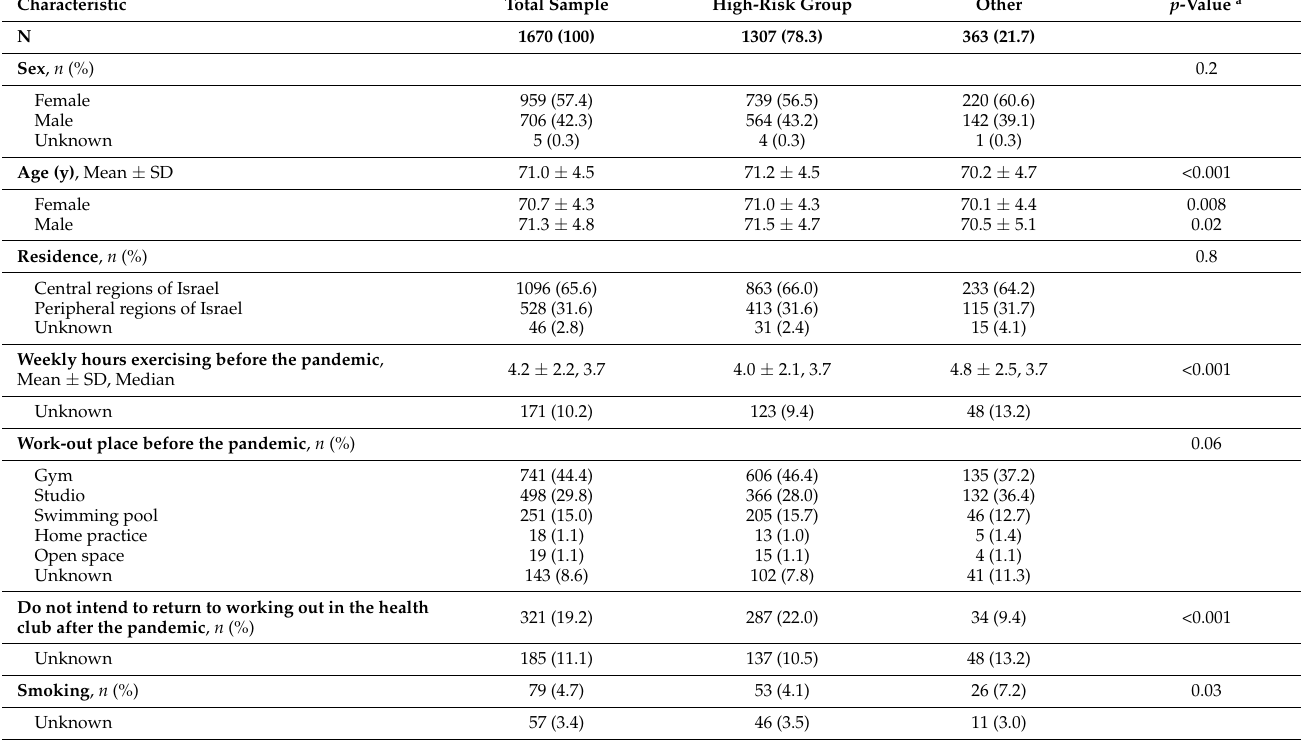
Table 1. Socio-demographic and health behavior characteristics of 1670 physically active older Israeli adult members of a health club chain, according to self-classification to COVID-19 level of risk